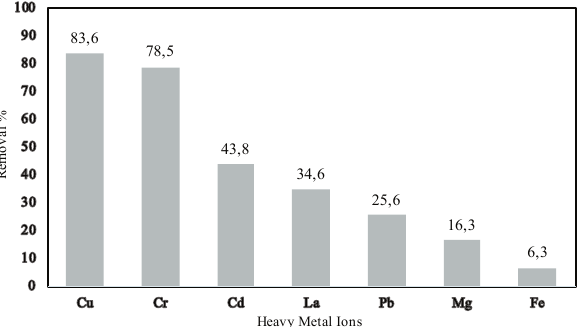
Figure 3. Removal rate of diff erent heavy-metal ions in a mixed aqueous solution using S-octanoyl-cysteine surfactant through a batch stage ion fl otation process (Reprinted from Ref. 12, with per- mission from